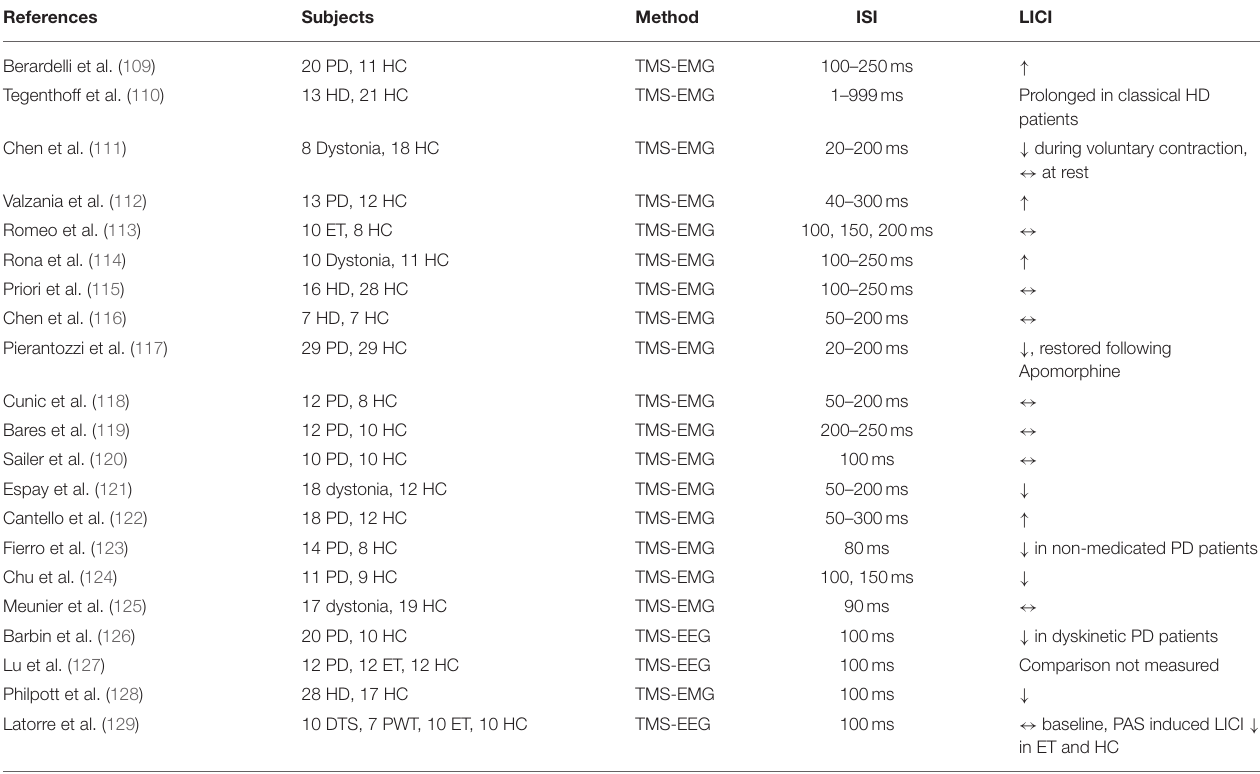
TABLE 10 | LICI in patients with movement